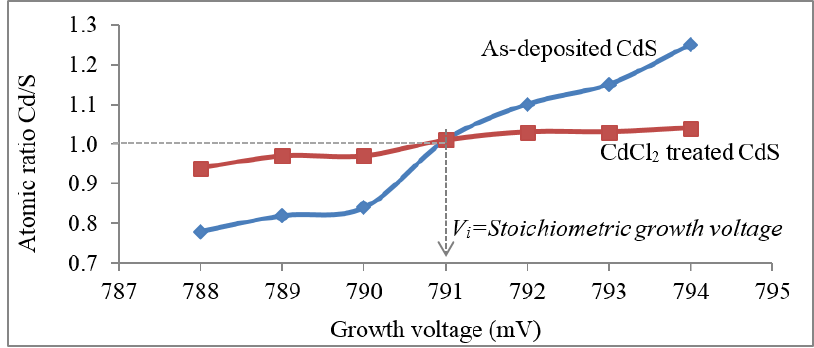
Figure 4. Atomic composition ratios of Cd to S in as-deposited and CdCl 2 treated CdS thin films at different deposition cathodic voltages.